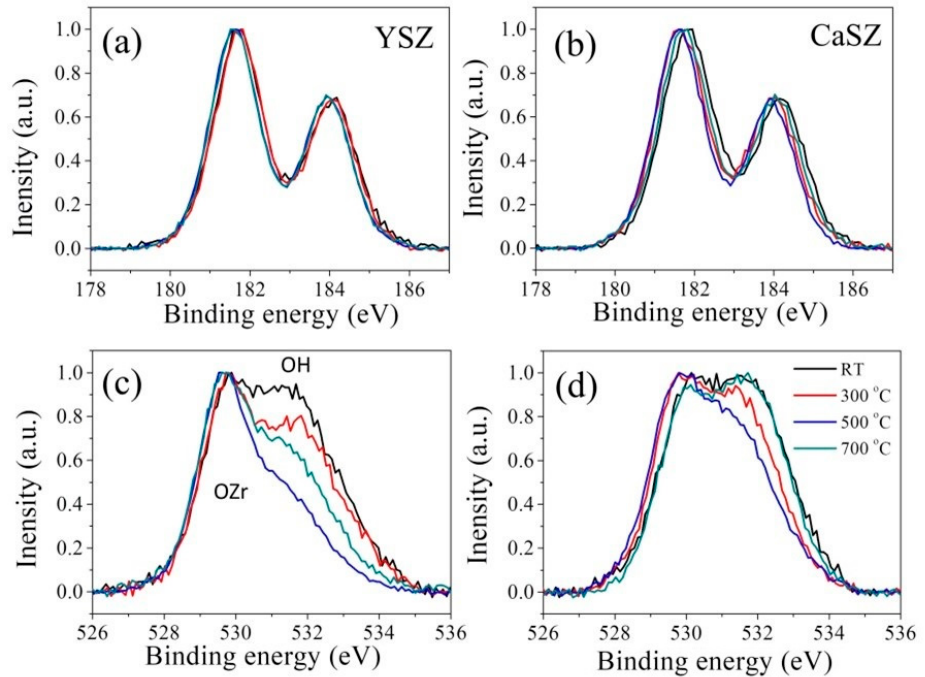
Figure 3. Variations of ( a , b ) Zr3d and ( c , d ) O1s XP spectra with thermal treatment temperature for the ( a , c ) YSZ and ( b , d ) CaSZ